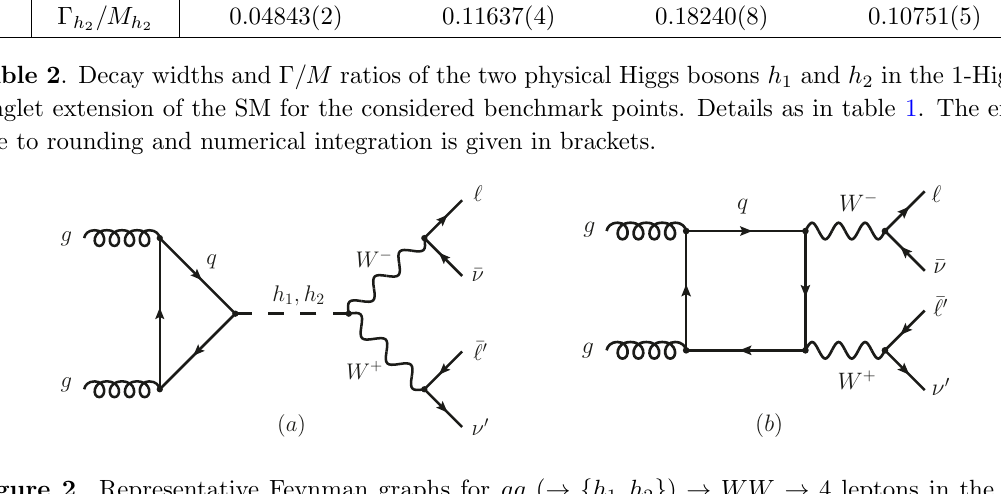
Figure 2 . Representative Feynman graphs for gg ( extended with a real scalar singlet (cid:12)eld. The light ( h 1 ) and heavy Higgs ( h 2 ) production